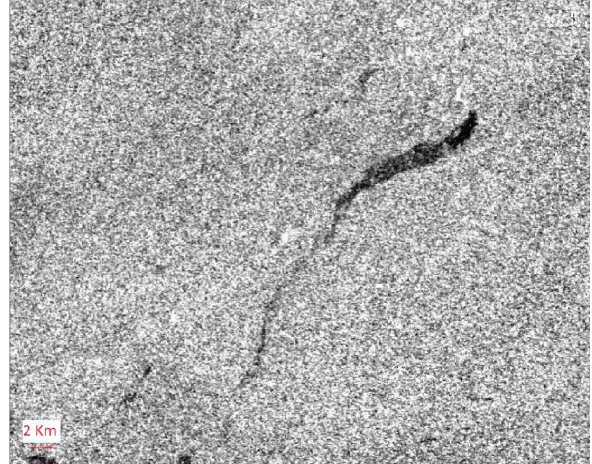
Figure 5e. ENVISAT WSM SAR image taken on the 20 th January 2004 on same area as Fig. 5a. Resolution is 150m.